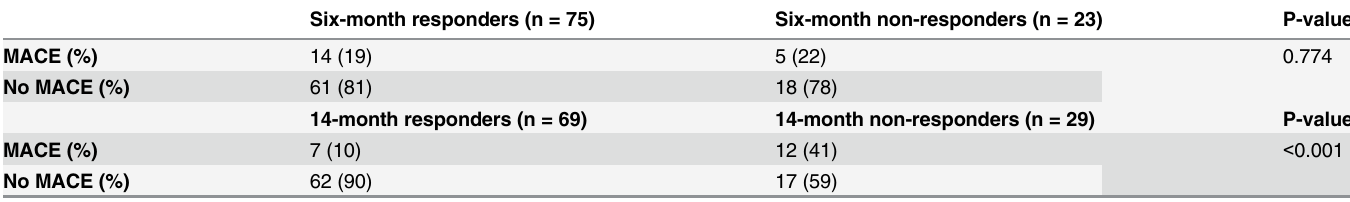
Table 3. MACE between 14 – 24 months after implantation in 6 and 14-month responders and